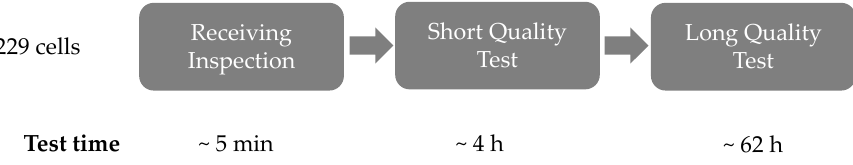
Figure 1. Test scheme for the analysis of the initial state of the cells after procurement.